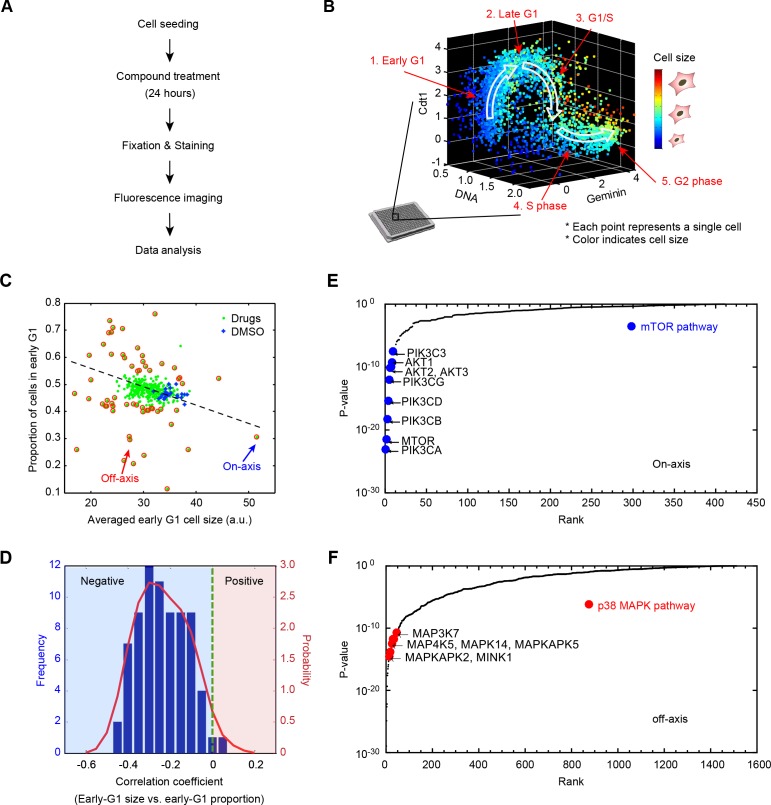
Results from a small molecule screen implicate the p38 MAPK pathway in the coordination of cell size and progression through G1.(A) A flowchart of the chemical screen demonstrating the major steps. (B) Raw data of cell size and cell cycle stage measured from a single control well in the screen. The scatter plot represents single-cell measurements of cell size and three markers of cell cycle stage; Cdt1 (mKO2-hCdt1), Geminin (mAG-hGem) and DNA (DAPI). Every point in the plot represents measurements on one single cell. Cell size is represented by a color scheme depicted by the colorbar on the right. White arrows are added to guide the reader along the cell cycle trajectory. (C) Average size of early G1 cells is negatively correlated with the fraction of cells in early G1. The scatterplot displays the result from one example 384-well plate. Each point on the plot corresponds to one particular screened condition (screened compound or control), and represents the average size of early G1 cells in that condition versus the proportion of cells in G1. Red circles highlight the conditions that significantly affect the size of early G1 cells and/or the proportion of cells in G1. The arrows designate examples of on-axis and off-axis compounds (also see Figure 1—figure supplement 3). (D) Distribution of correlation coefficients between average size of early G1 cells and the fraction of cells in G1, calculated for all screened plates (as described in Materials and methods - Analysis of the compound screen), demonstrating that the two variables are significantly negatively correlated (p<10−16). (E, F) Ranked p-values from the target enrichment analysis of on-axis and off-axis compounds, respectively (Fisher’s exact test). Components of the mTOR pathway and p38 MAPK pathway, which are highlighted, are among the top-ranked hits of on-axis and off-axis phenotypes, respectively. The Matlab script used to perform the target enrichment analysis is presented in Figure 1—source code 1.10.7554/eLife.26947.009Figure 1—source data 1.The screen metadata used to identify on-axis and off-axis outliers.10.7554/eLife.26947.010Figure 1—source data 2.The analysis script to visualize on-axis and off-axis outliers using Figure 1—source data 1.10.7554/eLife.26947.011Figure 1—source code 1.The Matlab script used to perform the target enrichment analysis.